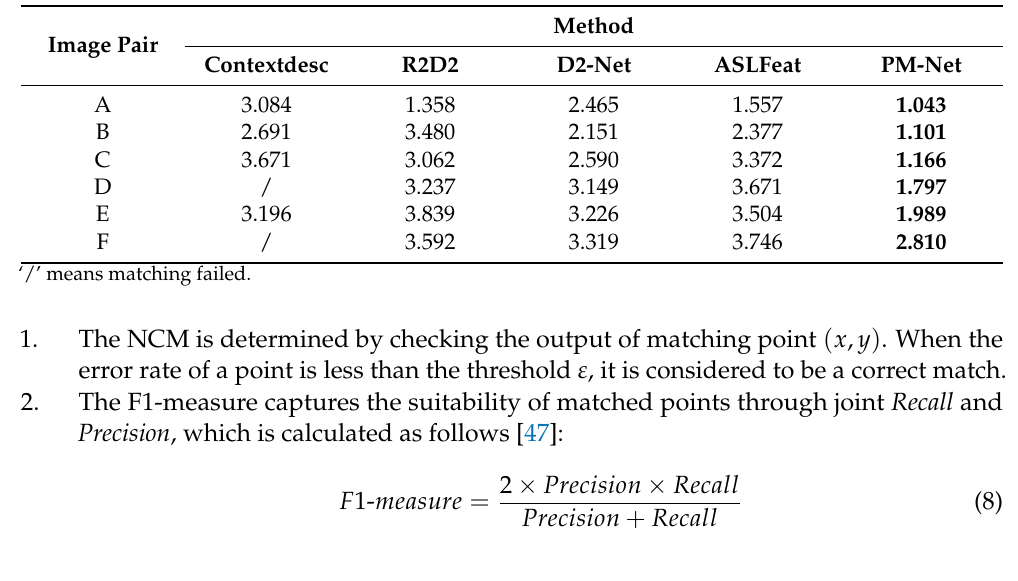
Table 3. Root mean square error of matching